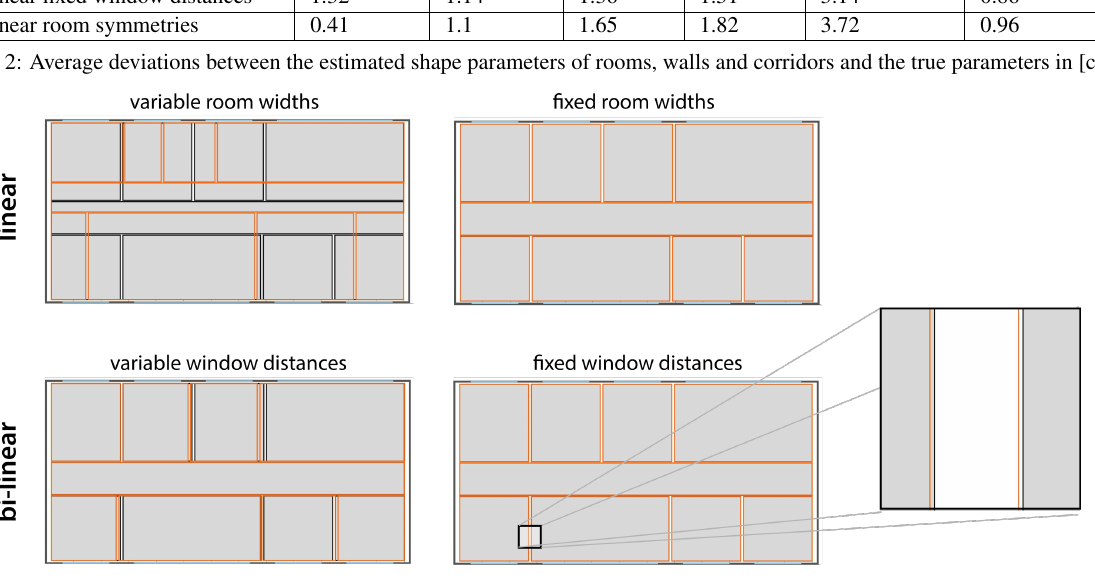
Figure 3: Floorplan estimation using our approach. Model selection is performed based on linear (top) and bi-linear (bottom) con- straints. Symmetries and repetitive patterns (fixed room widths, fixed window distances) are considered. The zoomed part on the right shows that the estimated (orange) and the ground truth model (black) are almost identical matrix of the estimated model is given